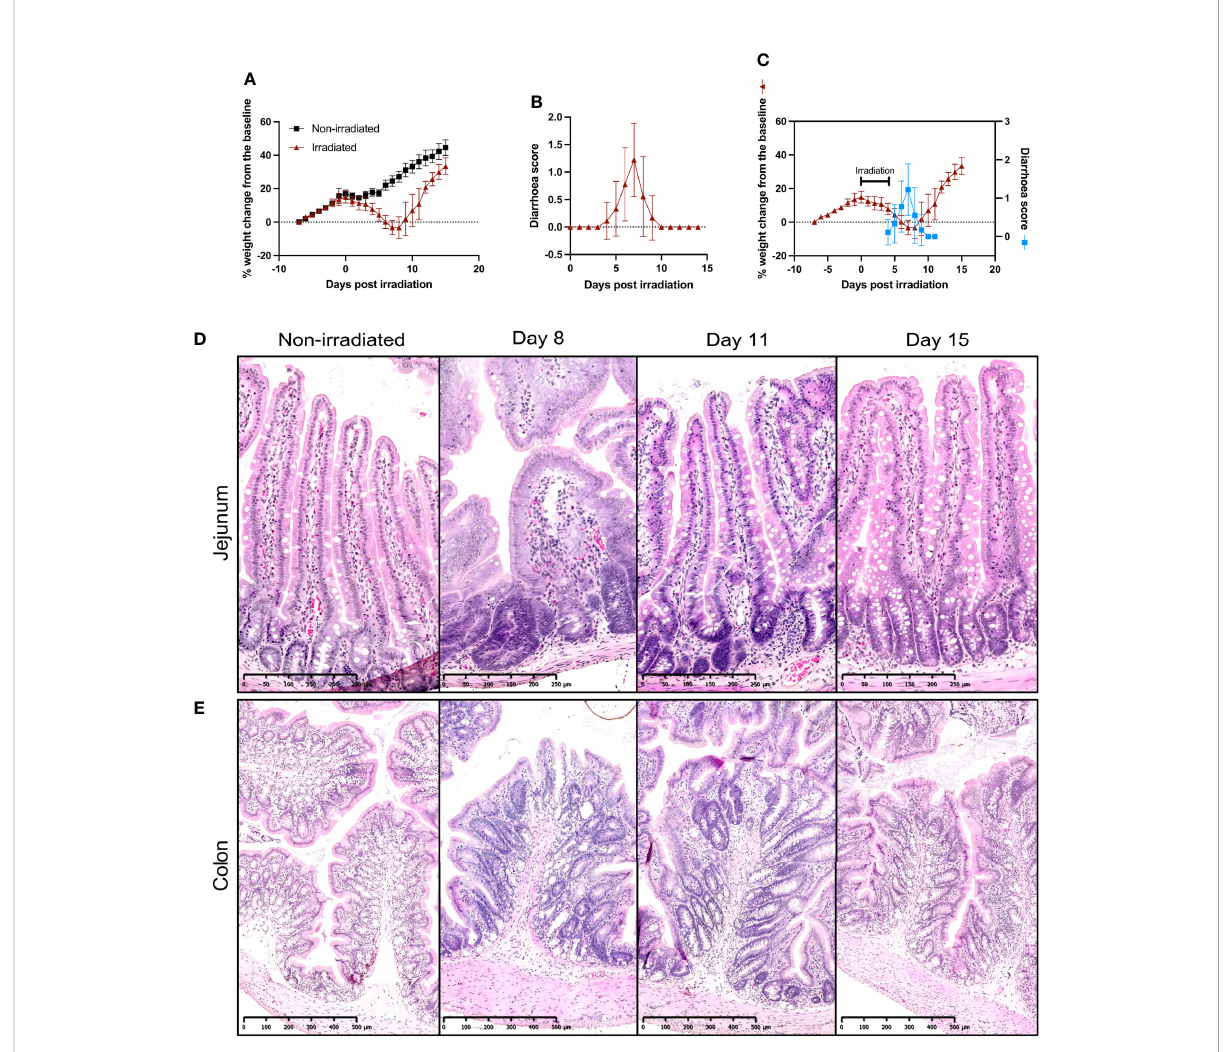
FIGURE 1 Establishment of fractionated radiation-induced GIM model in SD rats. (A) Body weight changes of irradiated and non-irradiated SD rats. Eight- week-old SD rats received fi ve fractions of 4-Gy radiation on their abdomen. The rats were weighed and recorded daily. (B) Diarrhea scores of irradiated SD rats. The animals were monitored daily for the presence and degree of diarrhea and given a score according to the scheme. (C) Overlay of body weight change and diarrhea scores of irradiated SD rats. (D, E) Representative images of H & E-stained jejunum (D) and colon (E) sections during GIM. The intestines were collected from irradiated rats on days 8, 11, and 15 and embedded in paraf fi n for H & E staining. Data are presented as mean ±